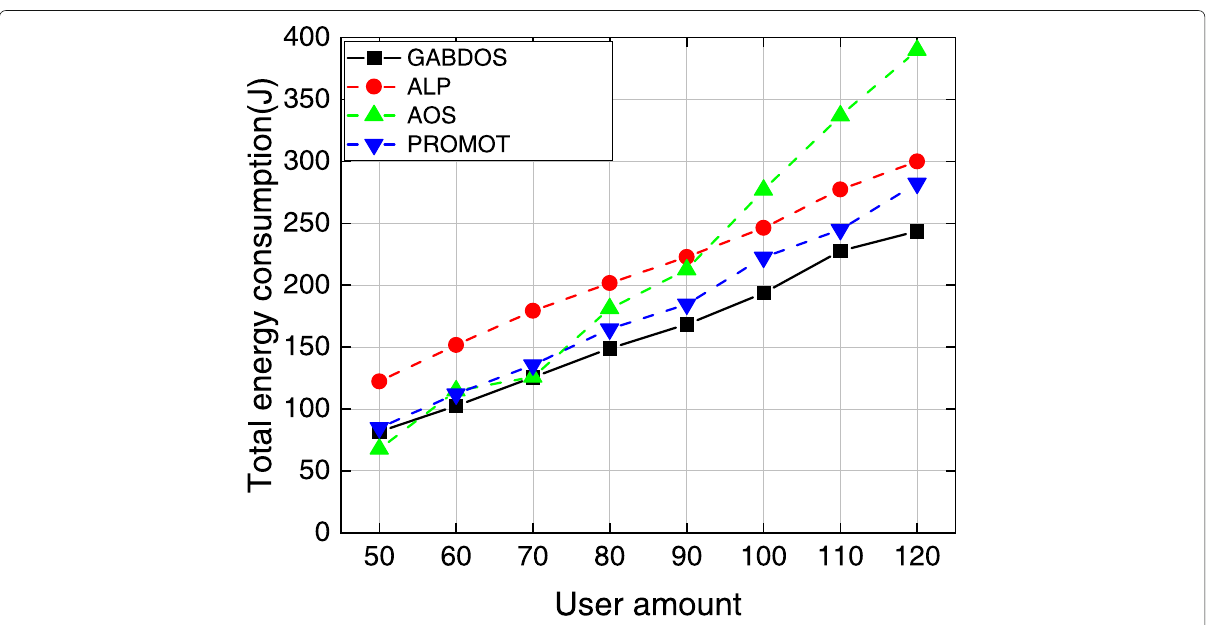
Fig. 7 Total energy consumption with different user amount